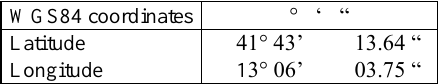
Figure 1. Graph of the NDVI / NDRE strength indicators